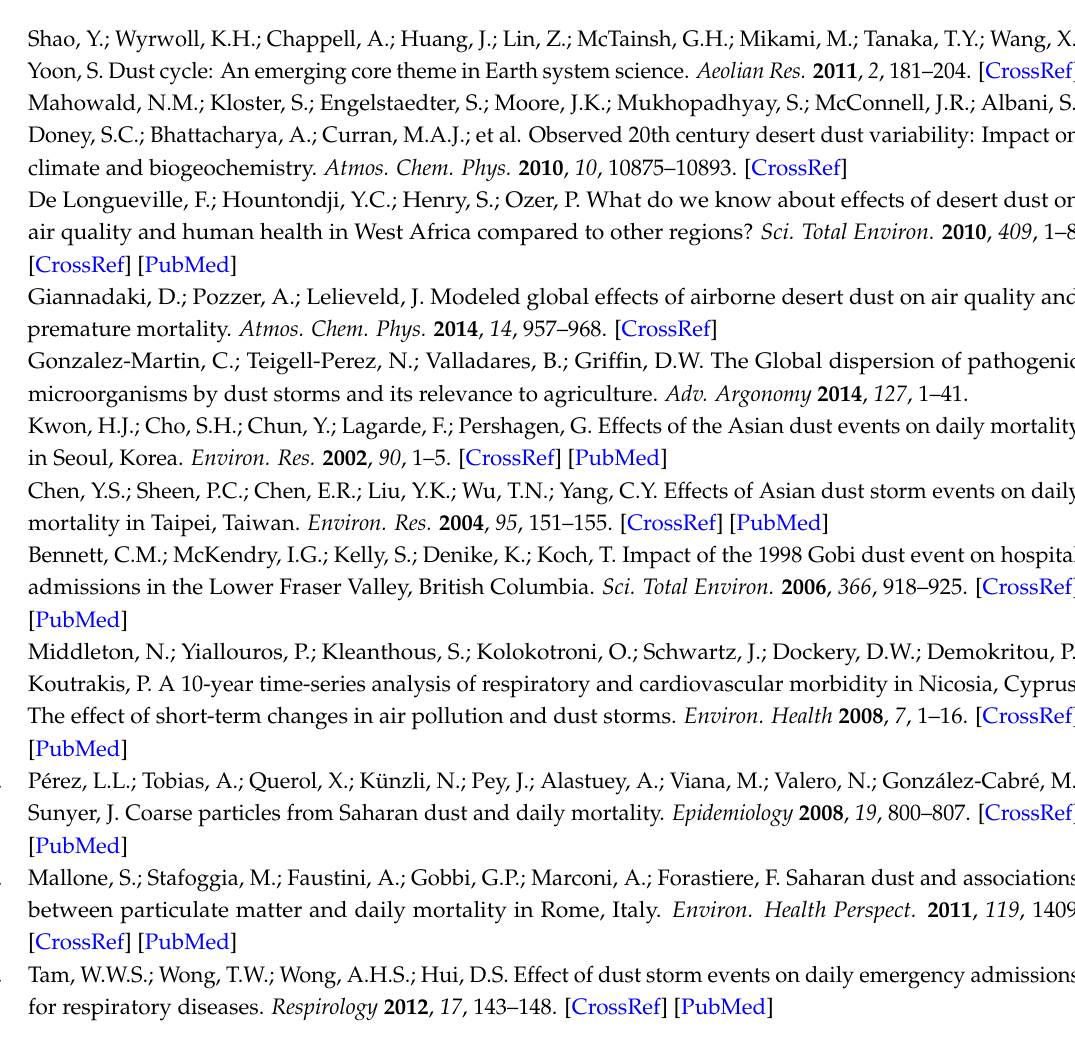
Table S1: Summary of total 103 epidemiological studies included with searching conditions for health effects of desert dust, Table S2: Summary of total 73 pathological studies included with searching conditions for health effects of desert dust, Table S3: Summary of total 54 general identified airborne microbiology studies related to dust storms over the